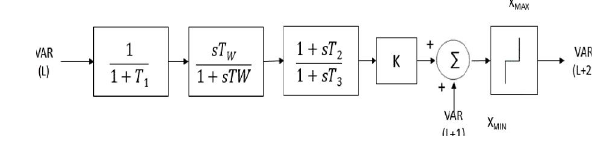
FIG. 3. CONTROL SYSTEM BLOCK DIAGRAM OF TCSC (CRANI)